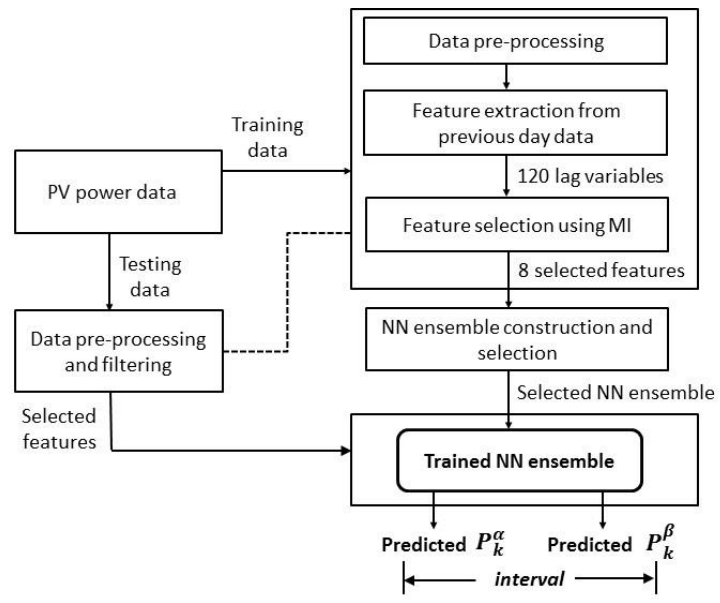
Figure 3. Block diagram of the proposed NNE2D approach.